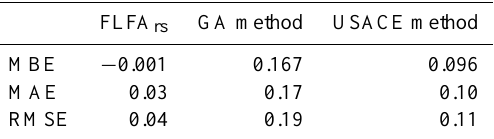
Table 5. Numerical comparison and error statistics of depth– damage function performance for the flood event of February 2012 (MBE: mean bias error; MAE: mean absolute error; RMSE: root mean squared error).